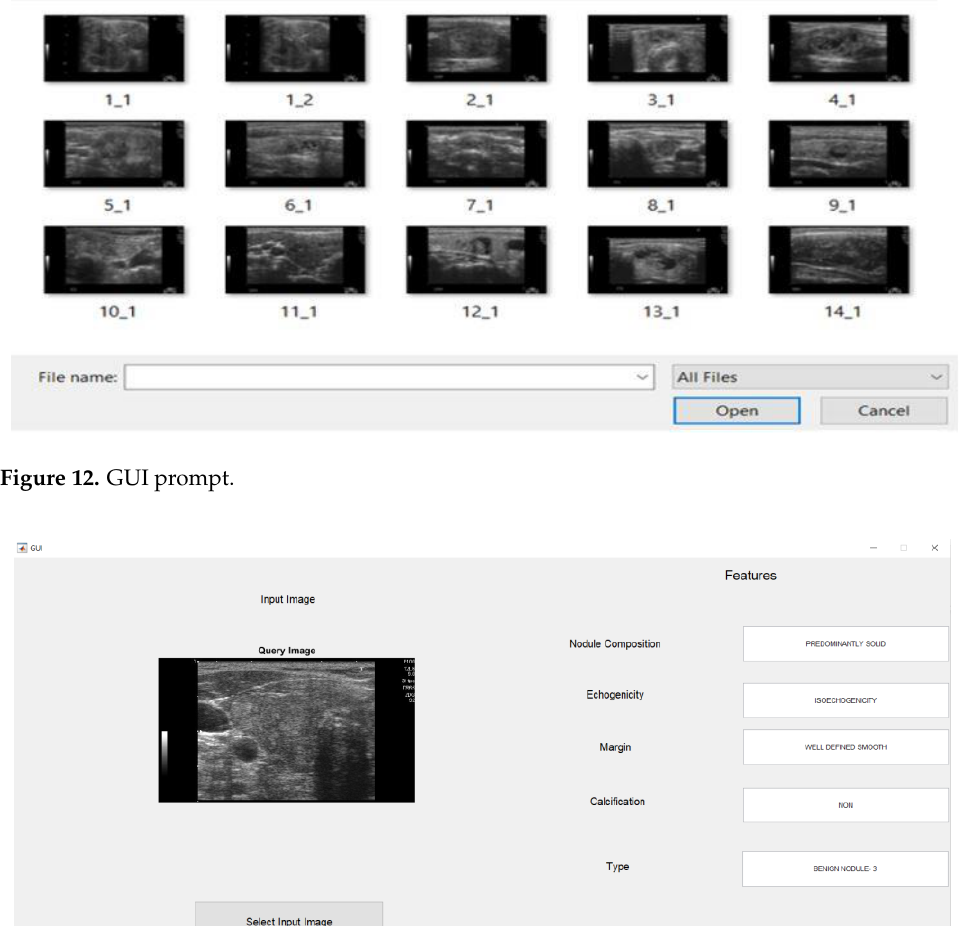
12 of 19 Table 2. Performance metric of ANN and SVM test phase. ROC Curve Parameters